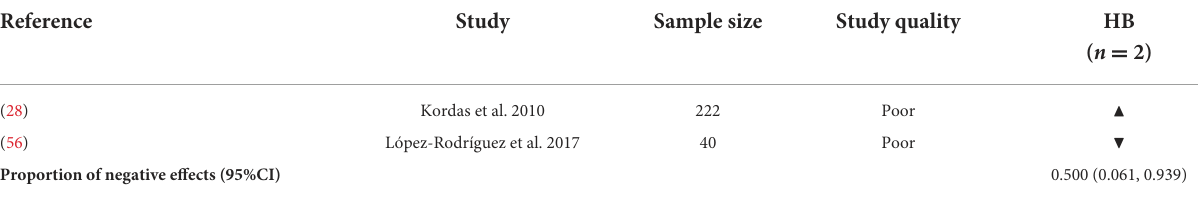
TABLE 4 Vote counting based on the direction of effect between arsenic concentration and red blood cell